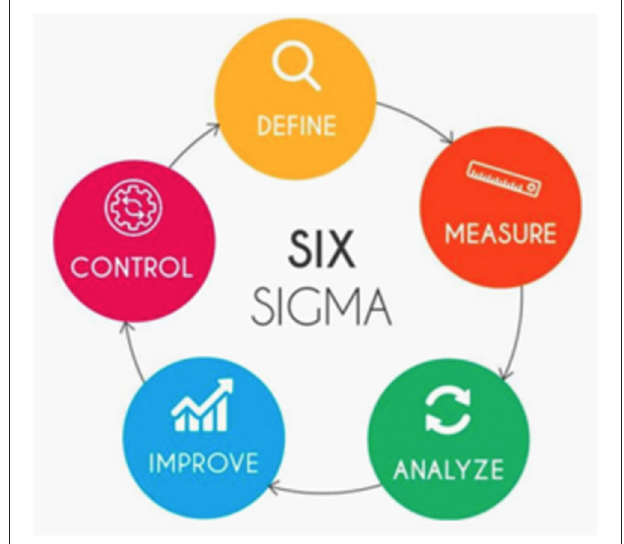
FIGURE 1 | Phases of the six sigma method. Image source: https://www.